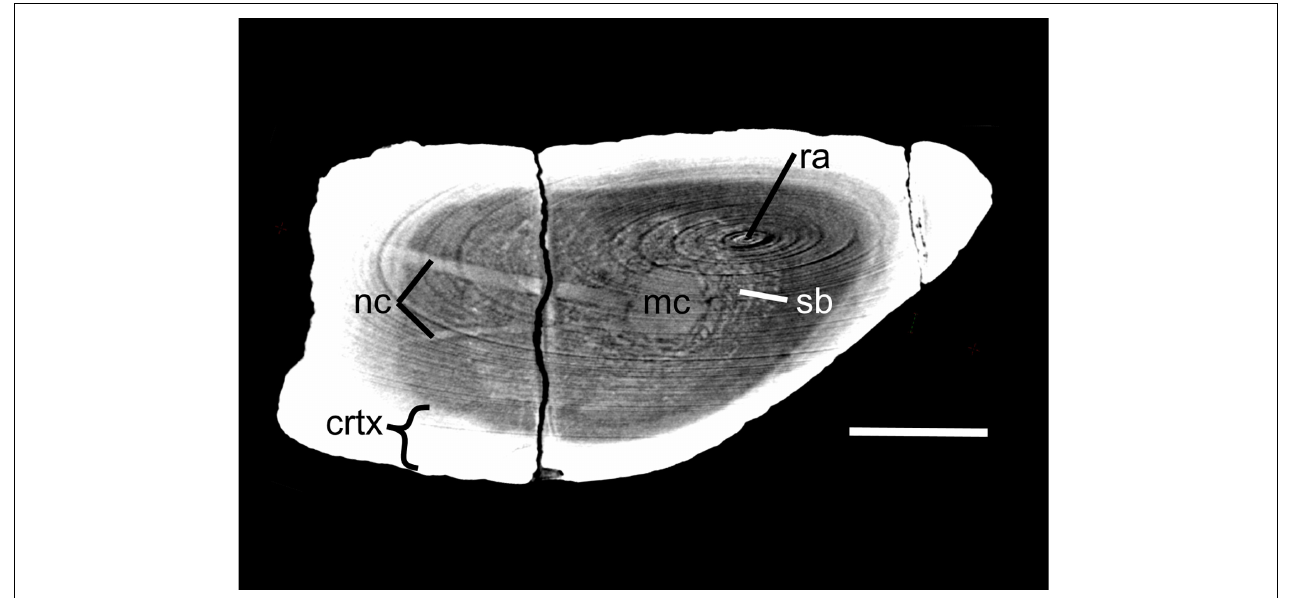
FIGURE 2 | Virtual cross section through the femur of Lystrosaurus sp. [Museum of Zoology, Cambridge, United Kingdom (UMZ T 767)]. Disregard ring artifacts (ra). Note the nutrient canals (nc) crossing the cortex (crtx) and spongy bone (sb) in the medullary region to feed into the center of the medullary cavity (mc) where the primary ossification center is located. When multiple nutrient canals were discovered, minimum cross-sectional area of each canal was added to calculate Q i . Scale bar equals 1 cm.